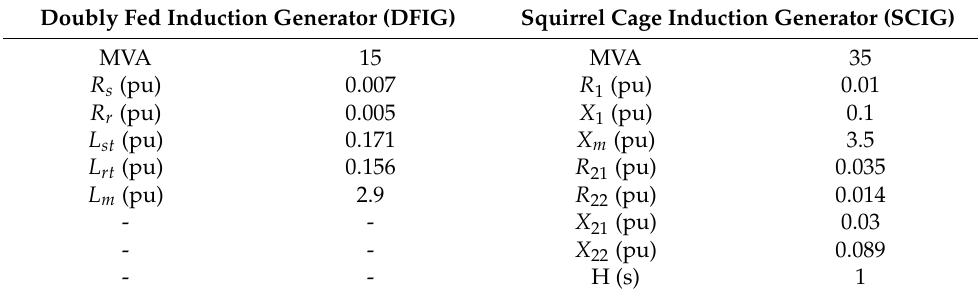
Table 1. Parameters of wind